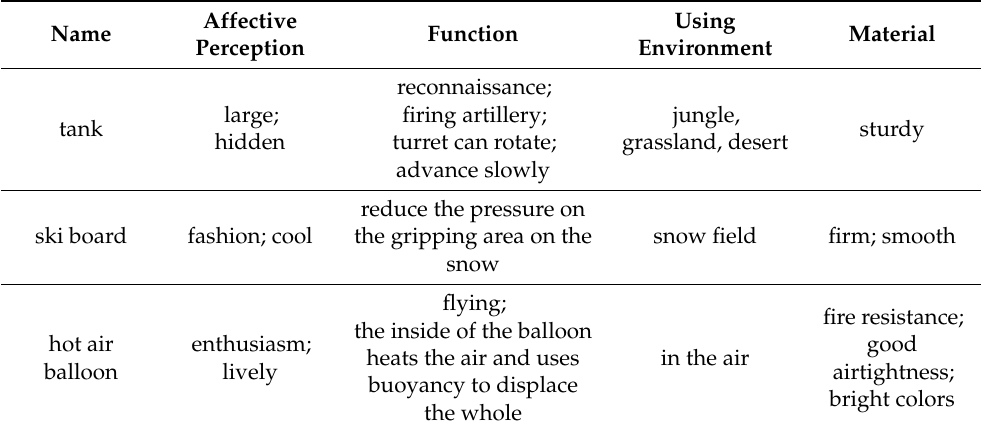
Table 12. Product description dataset (display part of